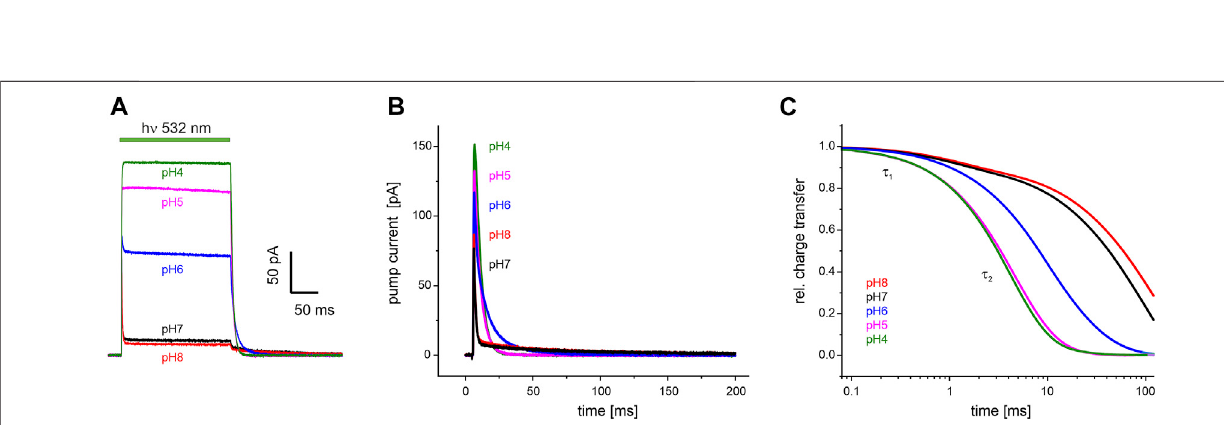
Frontiers in Molecular Biosciences |